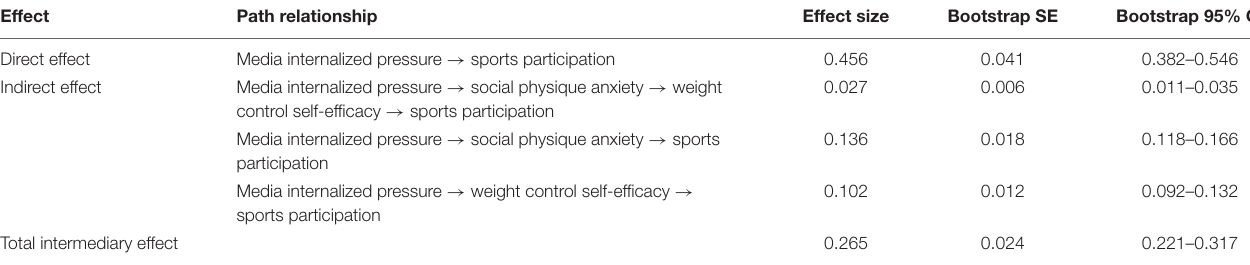
TABLE 5 | Path and effect decomposition table of media internalized pressure on sports